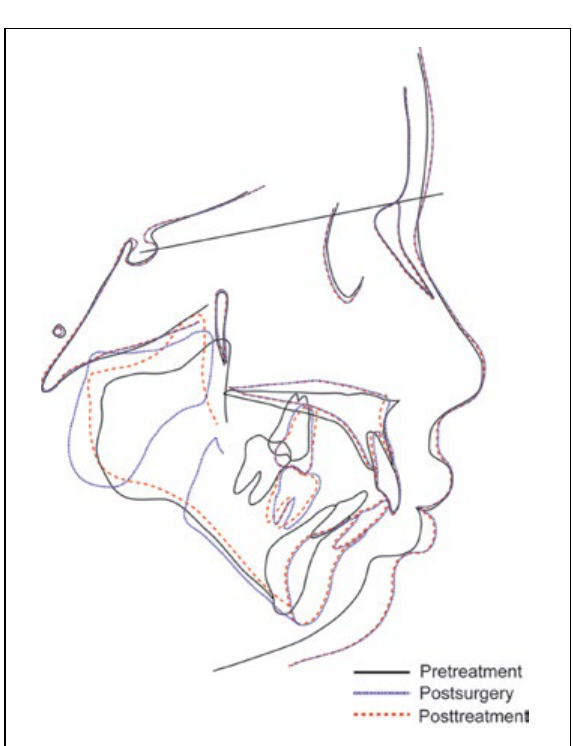
Figure 7. A superimposed tracing of lateral cephalograms of the pretreatment: black line; post second surgery: blue line; and post-treatment, two years and six months after surgery: red